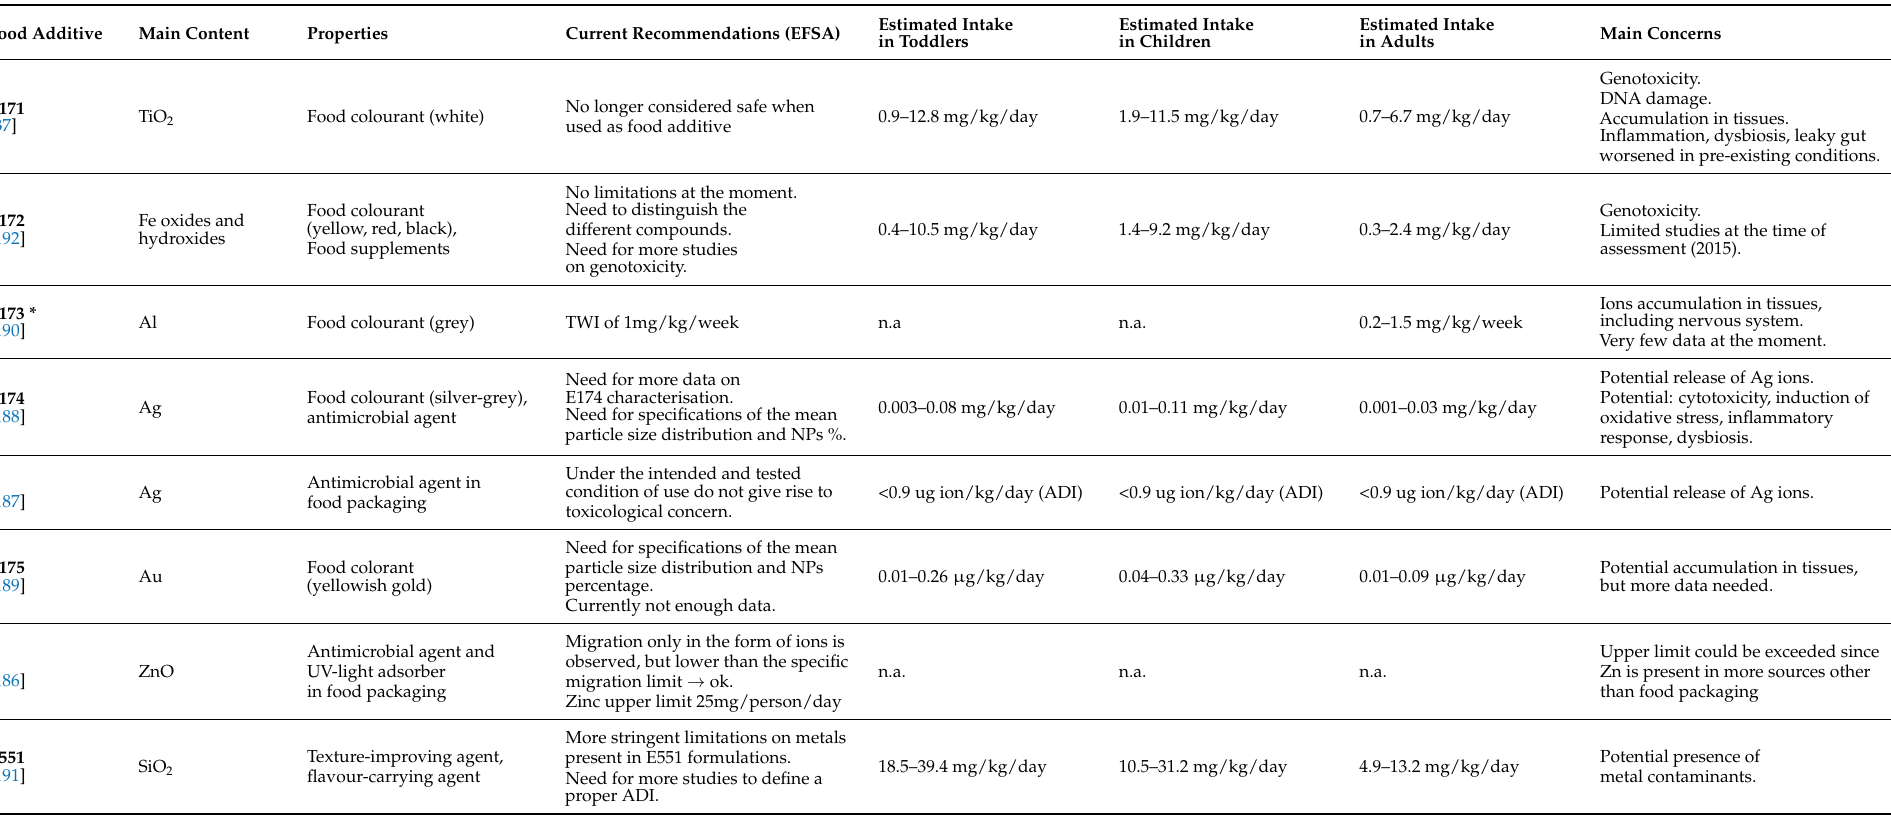
Table 4. Summary of the main food additives containing NPs used in food industry at the moment, their current regulations and estimated intakes according to EFSA and the main concerns raised in literature for their